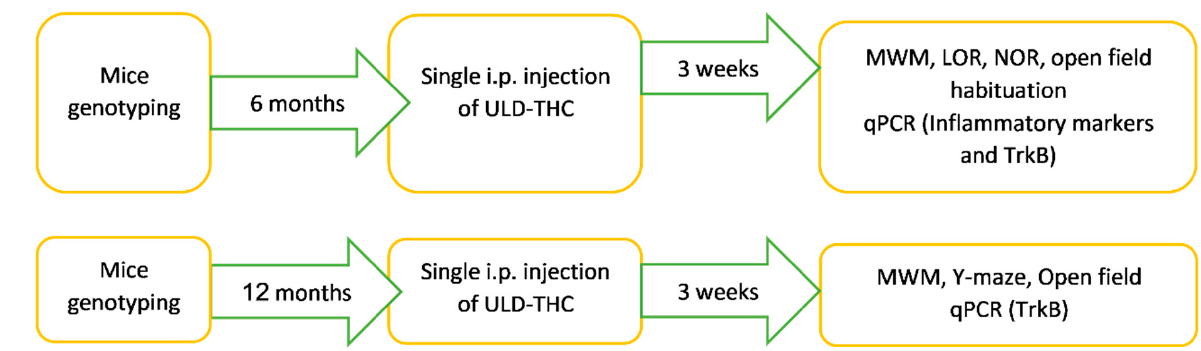
Figure 4. Study design. The 5xFAD tg mice model at different ages and their WT littermates were treated with a single i.p. injection of either ULD-THC or a vehicle and tested for short- and long-term spatial memory three weeks later.